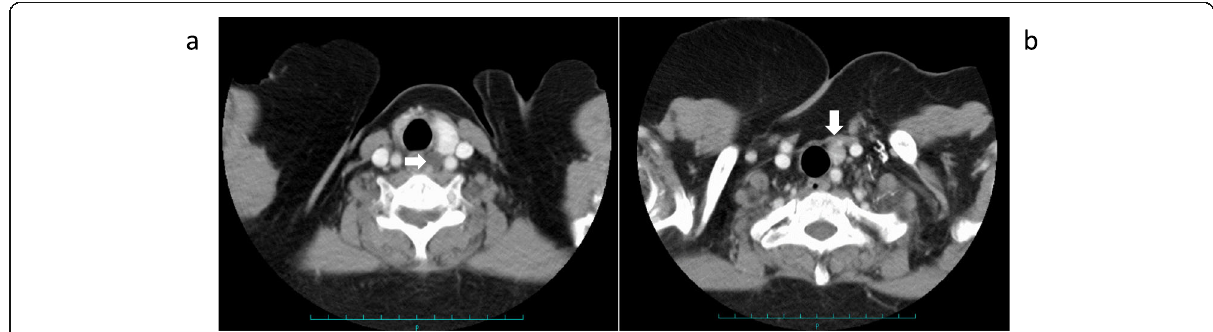
Fig. 3 CT findings of the neck. a A mass found behind the left thyroid lobe (arrow). b A mass found caudally next to the lower pole of the left thyroid lobe